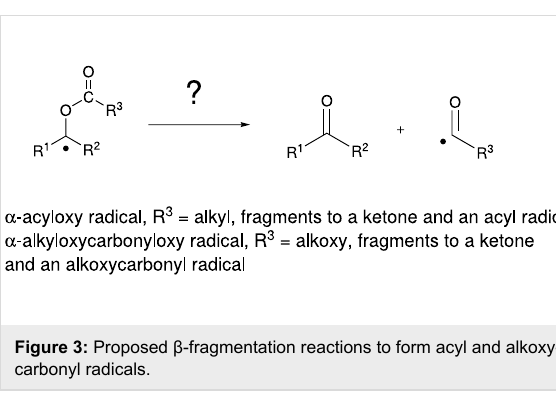
Figure 3: Proposed β-fragmentation reactions to form acyl and alkoxy- carbonyl radicals.